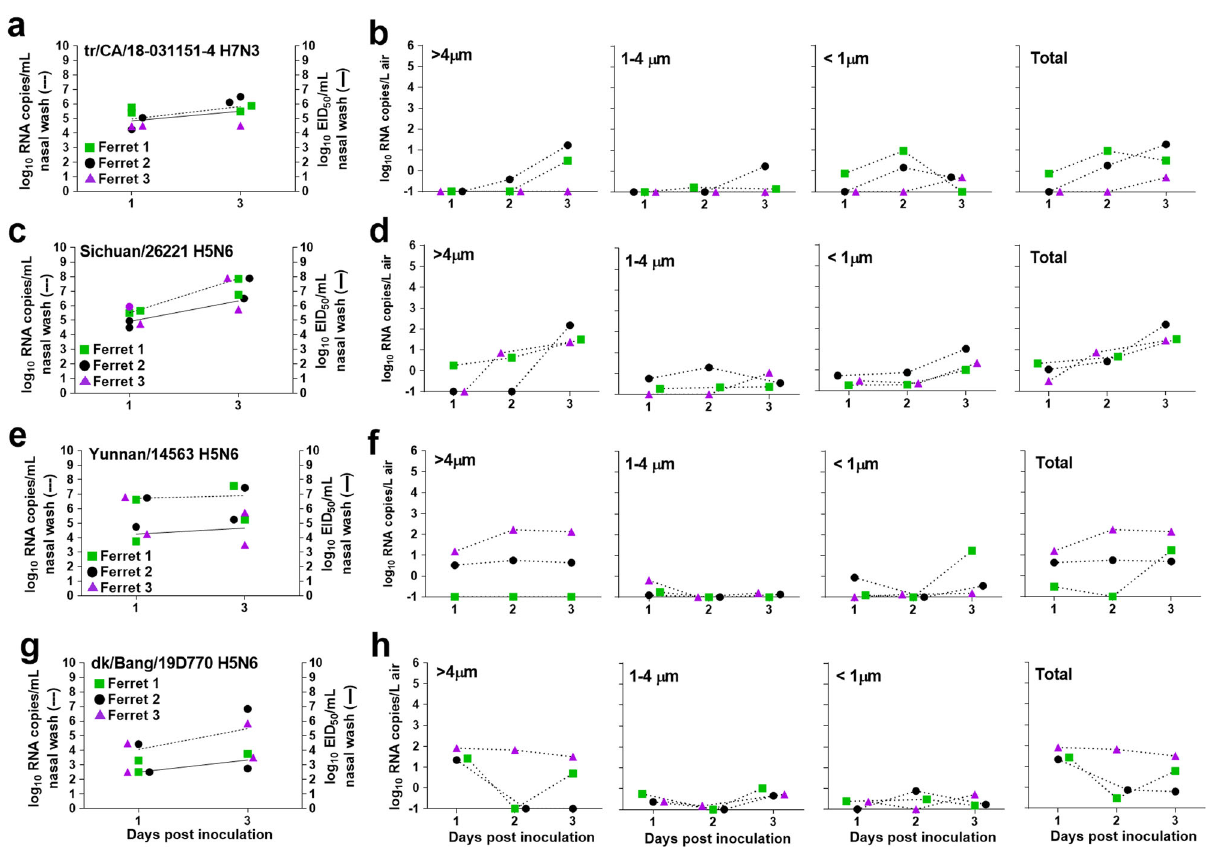
Fig. 3 Quanti fi cation of airborne viral RNA released from ferrets inoculated with poorly transmissible in fl uenza A viruses. Three ferrets per group were inoculated with A/turkey/California/18-031151-4/2018 A(H7N3) a , A/Sichuan/26221/2014 A(H5N6) c , A/Yunnan/14563/2015 A(H5N6) e , and A/duck/ Bangladesh/19D770/2017 A(H5N6) g . Infectious virus in nasal wash samples was quanti fi ed by egg titration (solid lines; data source listed in Table 1; limit of detection 1 log 10 EID 50 /ml), and viral RNA copies were quanti fi ed using real time qRT-PCR (dashed lines; data generated in this study; limit of detection 1 log 10 RNA copies/ml). Each individual ferret is shown as a different symbol (ferret 1-green square, ferret 2-black circle, ferret 3-purple triangle). Air samples were collected from each ferret cage for 2h on indicated days using a two-stage cyclone sampler which separated the aerosol particles based on size into three fractions: > 4 µ m, 1 – 4 µ m, <1 µ m. ViralRNA in each sample was quanti fi ed using real time qRT-PCR and the data for each virus; A/turkey/California/18-031151- 4/2018 A(H7N3) b , A/Sichuan/26221/2014 A(H5N6) d , A/Yunnan/14563/2015 A(H5N6) f , and A/duck/Bangladesh/19D770/2017 A(H5N6) h , and the individual ferret is shown (limit of detection 0.1 RNA copy/L of